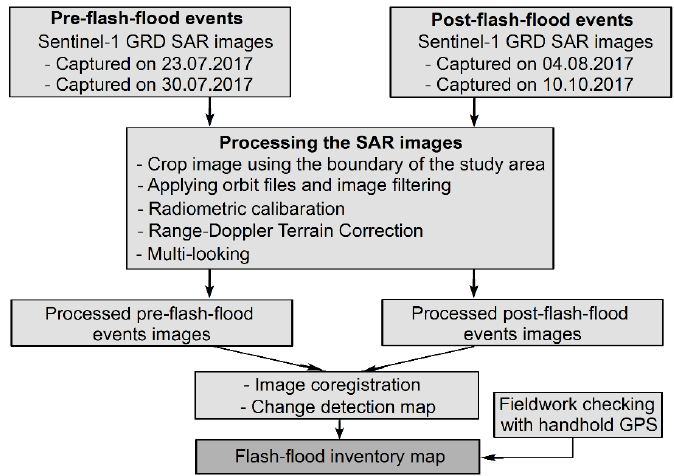
Figure 1. Methodological flow chart for flash-flood detection using the multi-temporal Sentinel-1 SAR images.